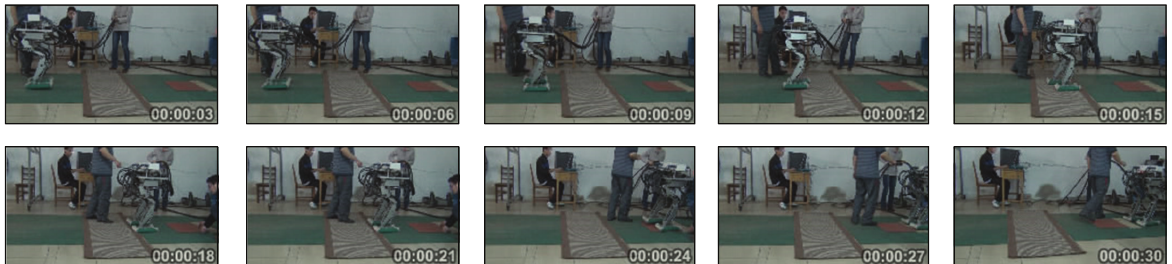
Figure 12: Physical prototype